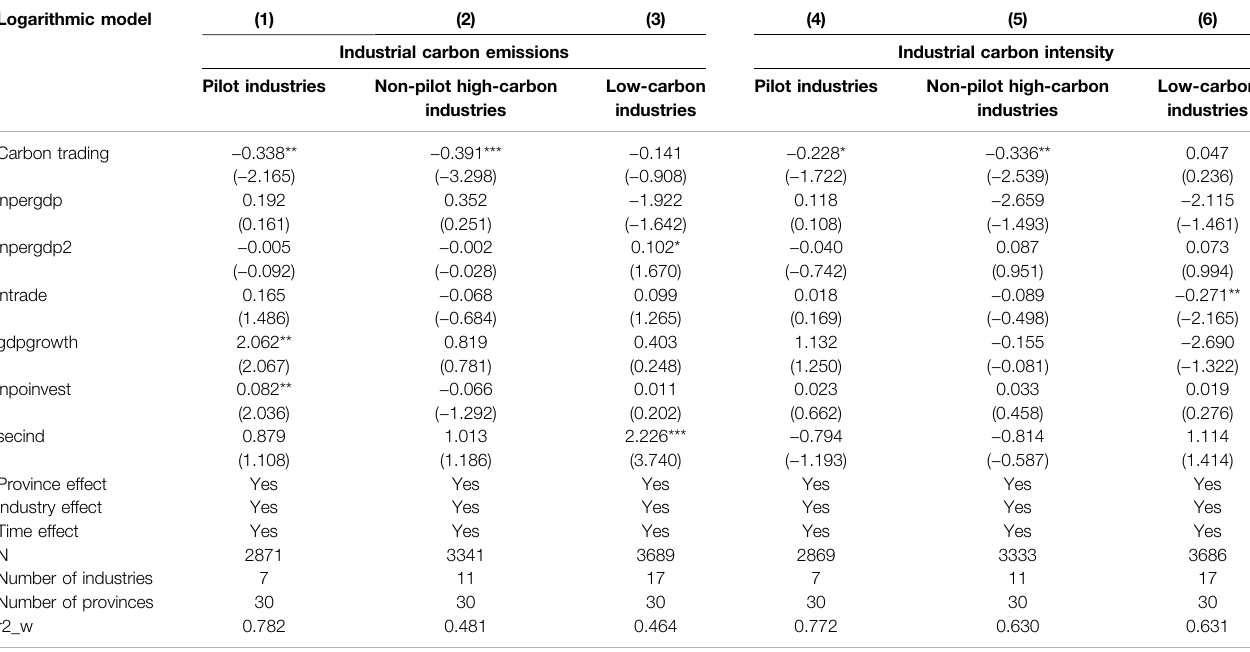
TABLE 7 | Impact of carbon trading on carbon emissions in different industries. Logarithmic